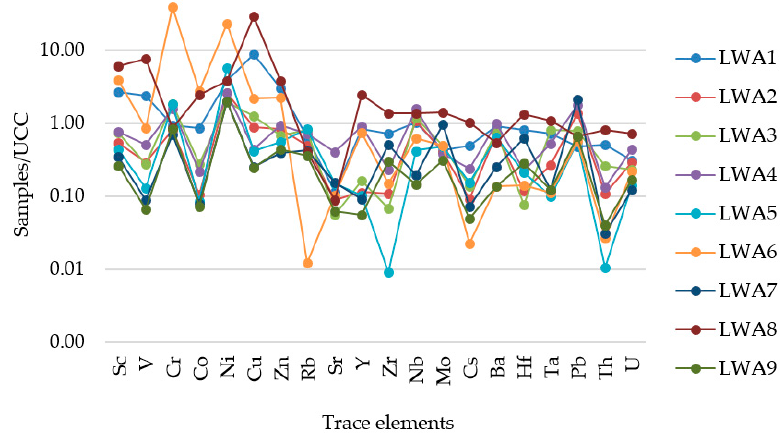
Figure 3. Upper continental crust (UCC) normalised trace element concentrations of the clay size fraction of the Lwamondo kaolin (arranged in increasing atomic number from Sc to U).